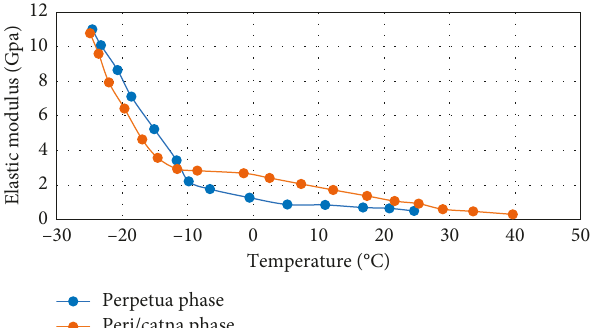
Figure 23: Effect of temperature on asphalt phases. The figure is reproduced from Fischer et al. [49] (under the creative commons attribution license/public